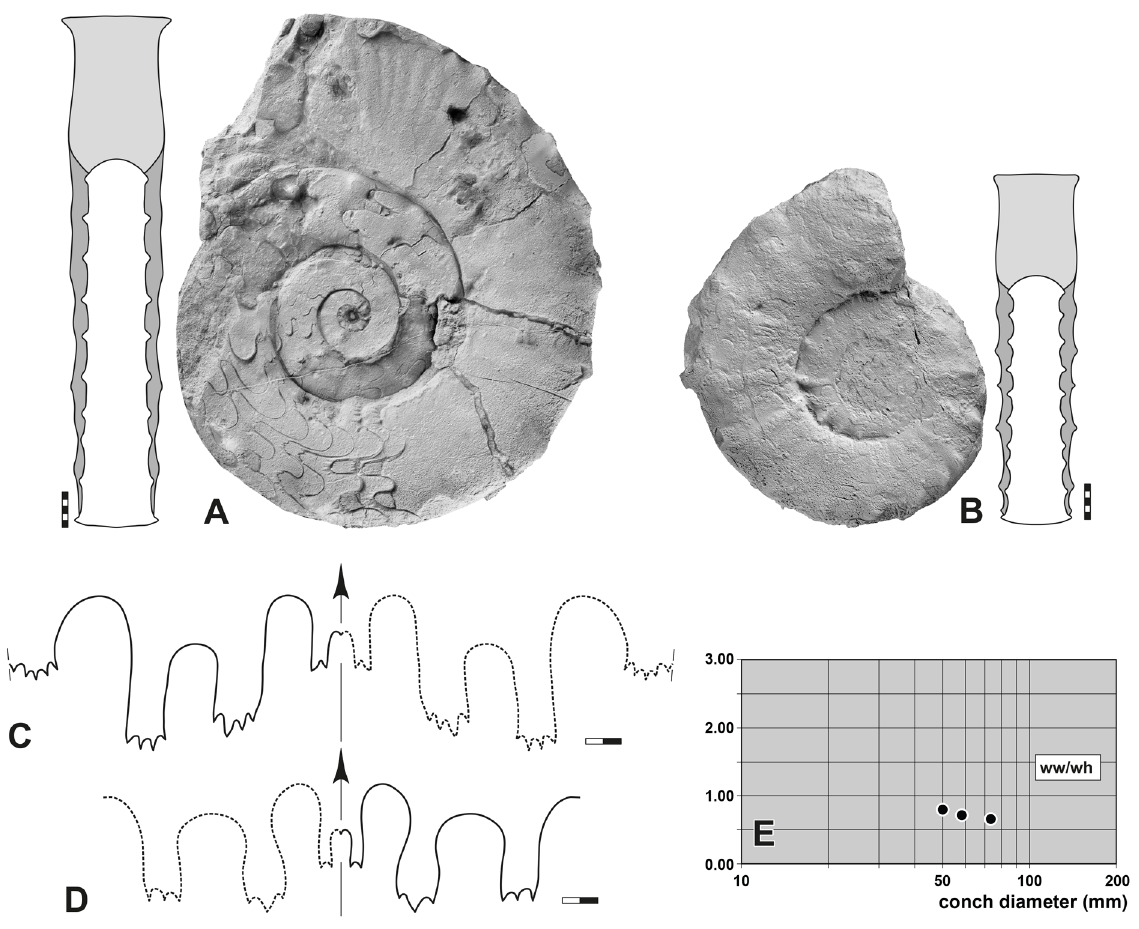
Fig. 61. Stoyanowites dieneri (Stoyanow, 1910). A . Lateral and dorsal view, specimen MB.C.30090, section E, float. B . Lateral and dorsal view, specimen MB.C.30089, section E, float. C . Suture line, specimen MB.C.30090, at 12.4 mm ww, 17.4 mm wh. D . Suture line, specimen MB.C.30089, at 14.4 mm wh. E . Whorl profile proportions. Abbreviations: see Material and methods. Scale bar units = 1 mm.